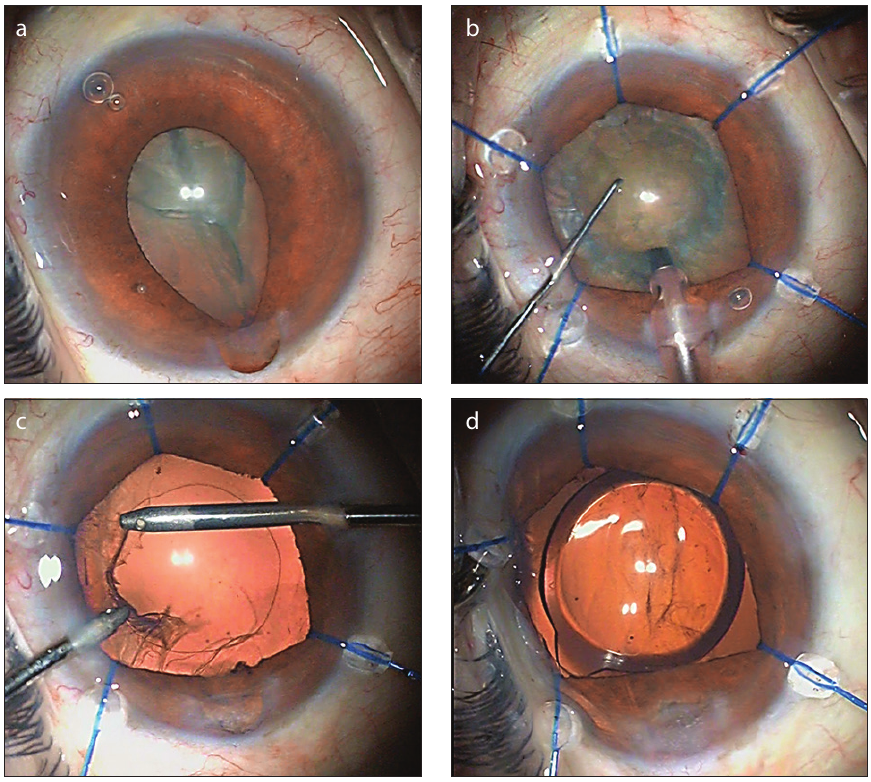
Figure 1. a-d. (a) Intraoperative floppy iris syndrome and iris prolapse during hydrodissection. (b) Placement of iris retractors before phacoemulsification. (c) Irrigation/aspiration of the cortex. (d) After intraocular lens